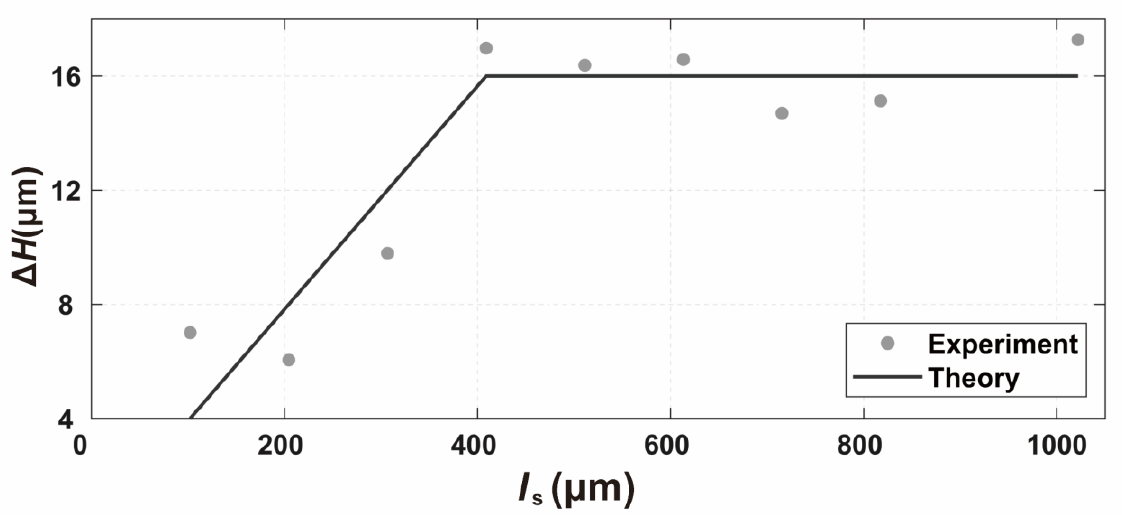
Figure 8. Relationship between the maximum height difference Δ H of the layer surface and the line spacing l s . The solid line represents the theoretical prediction, and the solid circles represent the experimental values.